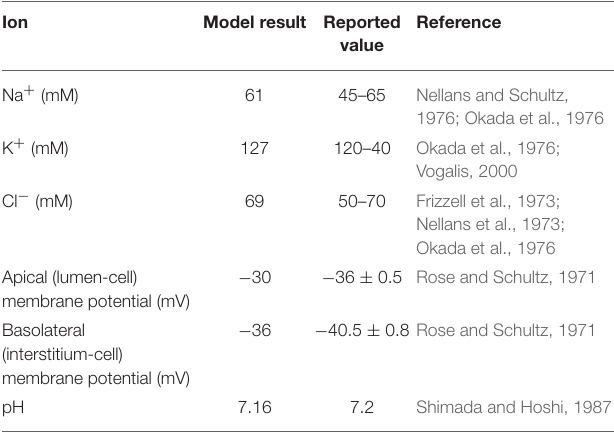
TABLE 2 | Reported values for intracellular ions concentration from simulated model and literature.